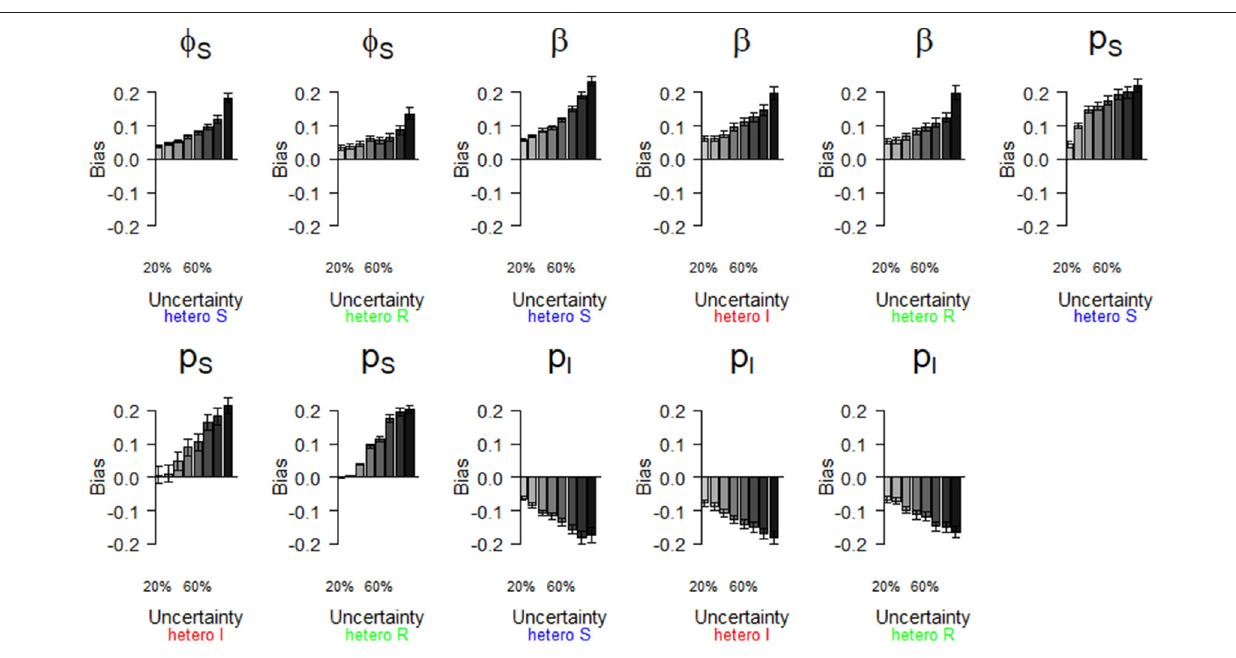
FIGURE 5 | Parameter estimates with a bias greater than |0.2| as a function of a heterogeneous increase in state uncertainty. Error bars represent 95% CI. The increasing state uncertainty corresponds to a decreasing probability of assigning an infection state. We used the following notations for the parameters: φ S for the survival probability of individuals in the S state, β for the infection probability, p S and p I for the detection probability of individuals in S and I states, respectively. Scenarios of assignment heterogeneity were reducing by 50% the assignment probability of the S state compared to the assignment probability of the I and R states (“hetero S” (blue)), reducing by 50% the assignment probability of the I state compared to the S and R states (“hetero I” (red)) and reducing by 50% the assignment probability of the R state compared to S and I states (“hetero R”